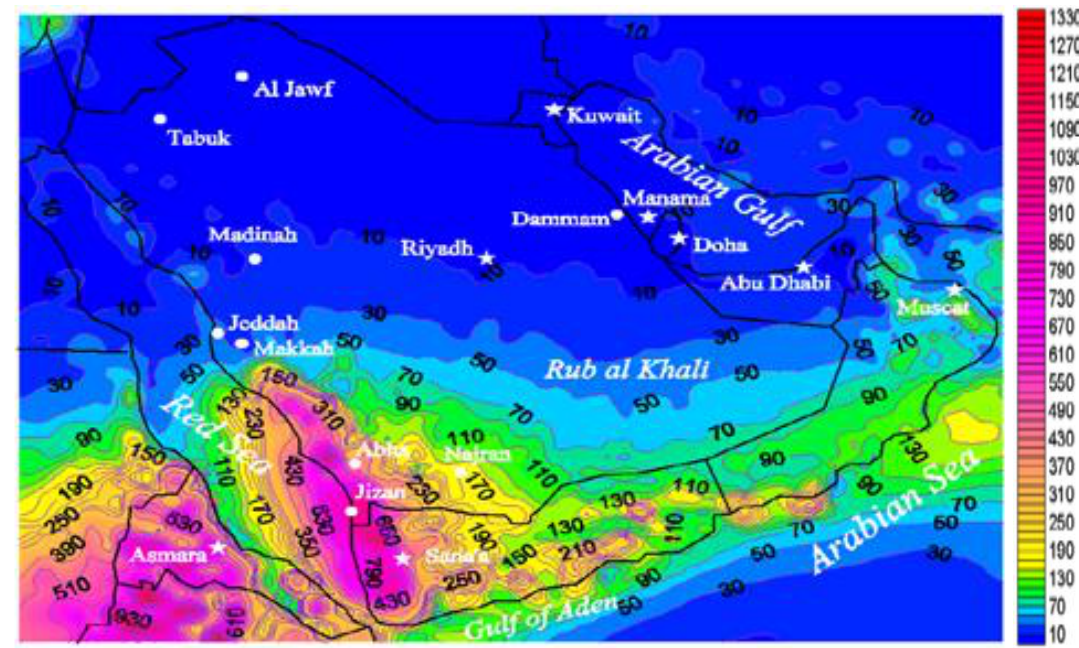
Figure 23. The spatial distribution pattern of the mean totalsummer precipitation over the 2070–2100 periodprecipitation [39].